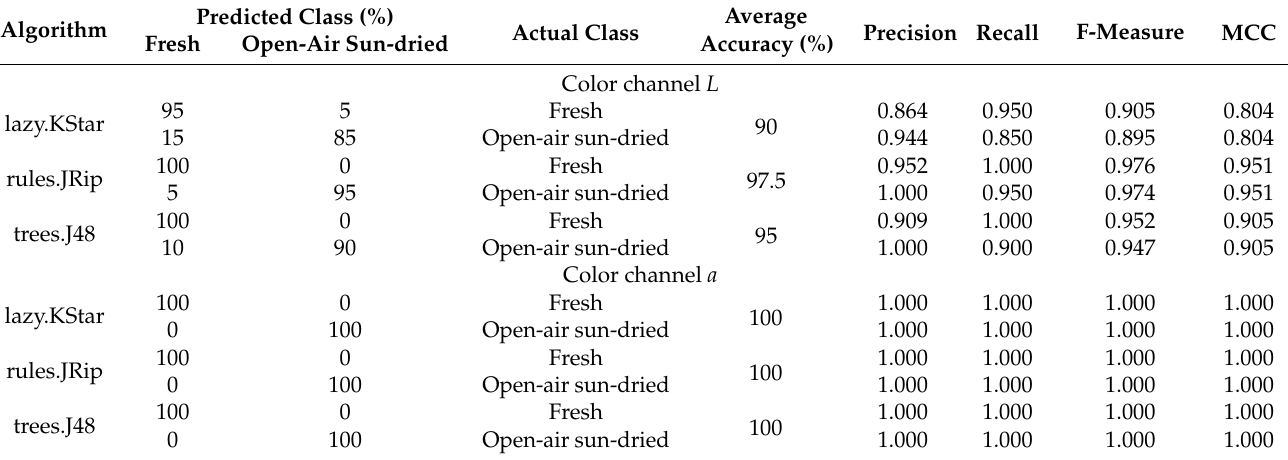
Table 11. The distinguishing of fresh and open-air sun-dried mint leaves imaged on the dorsal side using models developed based on selected textures from color channels L , a , and b from color space